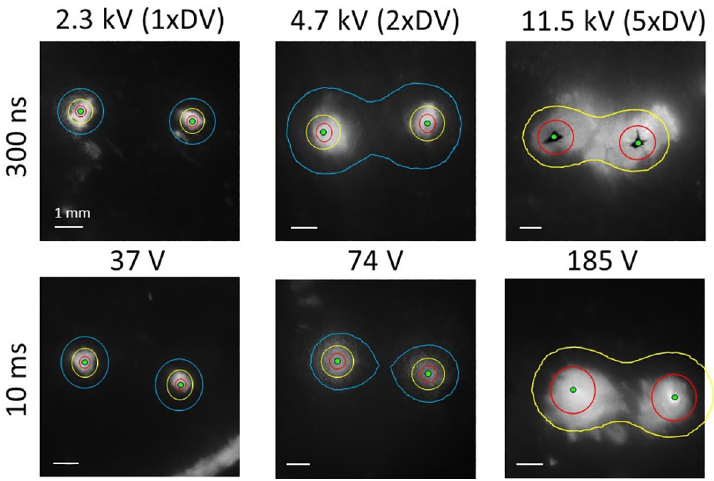
Fig 5. PI staining of cardiac surface for 300 ns and 10 ms shocks of different field strength. A) Representative PI staining examples for both 300 ns and 10 ms with applied voltages corresponding to 1, 2, and 5 defibrillation thresholds at 1 mm from the electrodes. The isolines show where the field strength equals to 15 E max,DV (red), 6 E max, DV (yellow), and 3 E max,DV (blue). In the case of the strongest applied voltage, the 3 E max,DV isoline is omitted because it runs mostly outside the field of view. B) Safety factor for the surface staining results for 300 ns (n = 26) and 10 ms shocks (n = 23). The averages are denoted with an “x”, the box shows the first quartile to the third quartile with the median intersecting the box, and the whiskers denote the maximum and minimum.